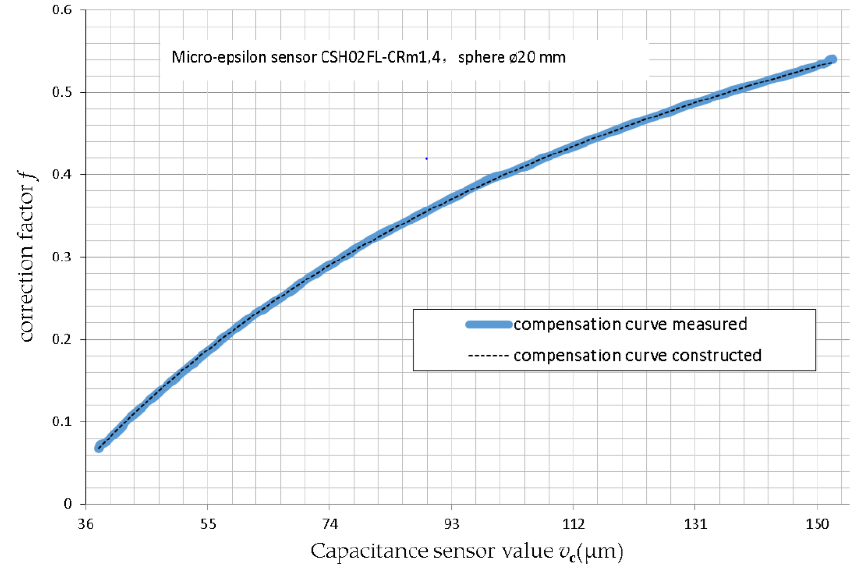
Figure 8. Nonlinear error compensation coefficient of a capacitive sensor on sphere (average effect).